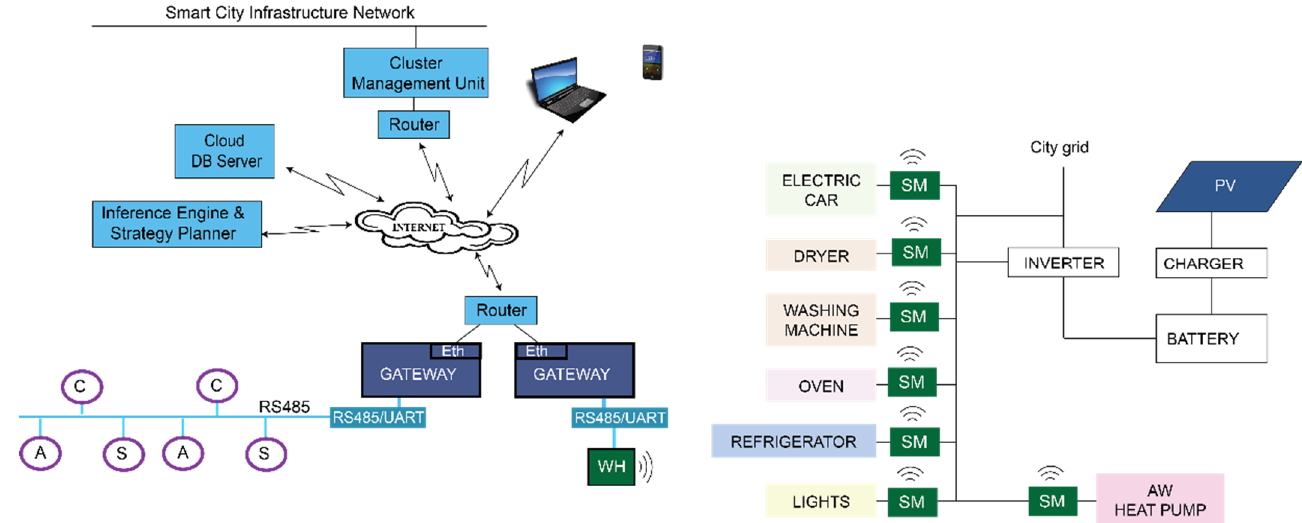
Figure 9. Integrated smart-home architecture.